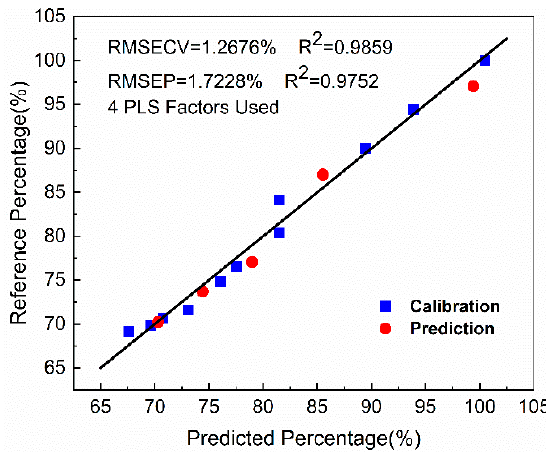
Figure 8. Reference versus predicted degree of PP degradation based on the partial least squares (PLS) model of the calibration and prediction set. RMSECV = the standard error of cross-validation; RMSEP = the standard error of prediction.